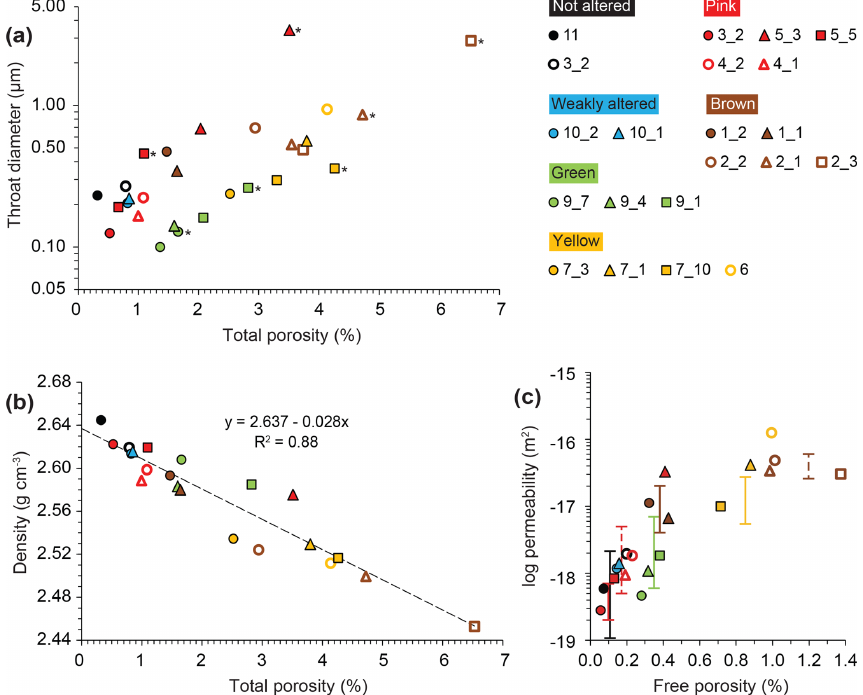
Figure 11. Plots of measured throat diameter, porosity, density and calculated permeability. (a) Volumetric median throat diameter versus total porosity. For all specimens the values were calculated for the throat diameter interval 0.005–5µm and for specimens with macroscopic voids also for the interval 0.005–300µm (denoted by an asterisk to the right of the symbols); (b) bulk density versus total porosity. Total porosity calculated for the throat diameter intervals 0.005–5 and 0.005–300µm for specimens without and with macroscopic voids, respec- tively; (c) point symbols: permeability calculated after Katz and Thompson (1986, 1987) from the total porosity and median throat diameter (calculated for throat diameter interval 0.005–5µm) versus free porosity measured by mercury reintrusion (failed for specimen 7_3), bars: intervals of permeability measured by gas permeametry on